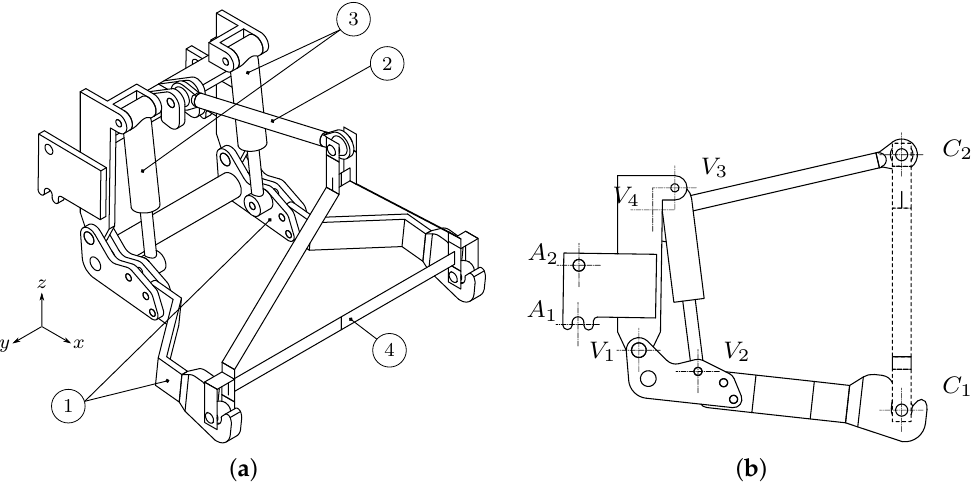
Figure 3. Front-mounted three-point linkage: ( a ) Assembly; ( b ) Boundary nodes of the reduced- order